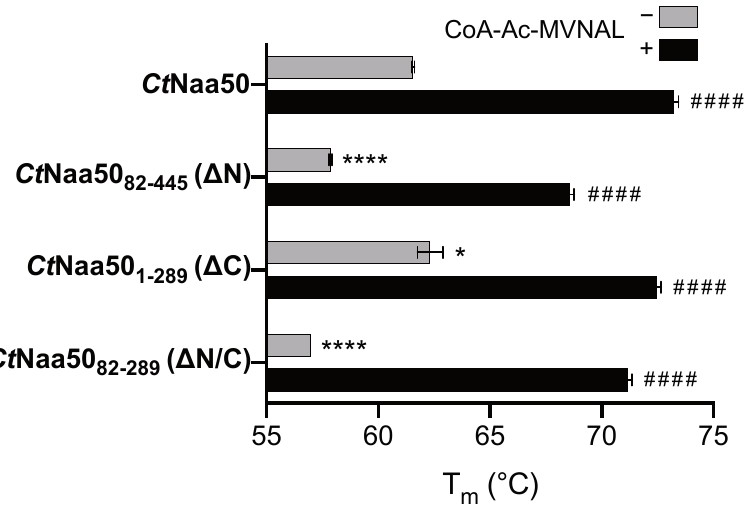
Figure 4. Ct Naa50 constructs containing the N-terminal extension have an increased thermostability. Ct Naa50 and Ct Naa50 1-289 feature the highest melting temperatures without the bisubstrate analog CoA-Ac-MVNAL. All constructs bind CoA-Ac-MVNAL, as highlighted by a dramatic increase in thermostability when incubated with tenfold molar excess. The melting temperatures of Ct Naa50 variants without CoA-Ac-MVNAL were compared against Ct Naa50 with a one-way ANOVA statisti- cal analysis with Dunnett’s correction (* = p -value ≤ 0.0332, **** = p -value ≤ 0.0001). The melting temperatures with CoA-Ac-MVNAL were compared against melting temperatures without CoA-Ac- MVNAL with a t test (#### = p -value ≤ 0.0001). All measurements were performed in triplicates and are presented as means ±